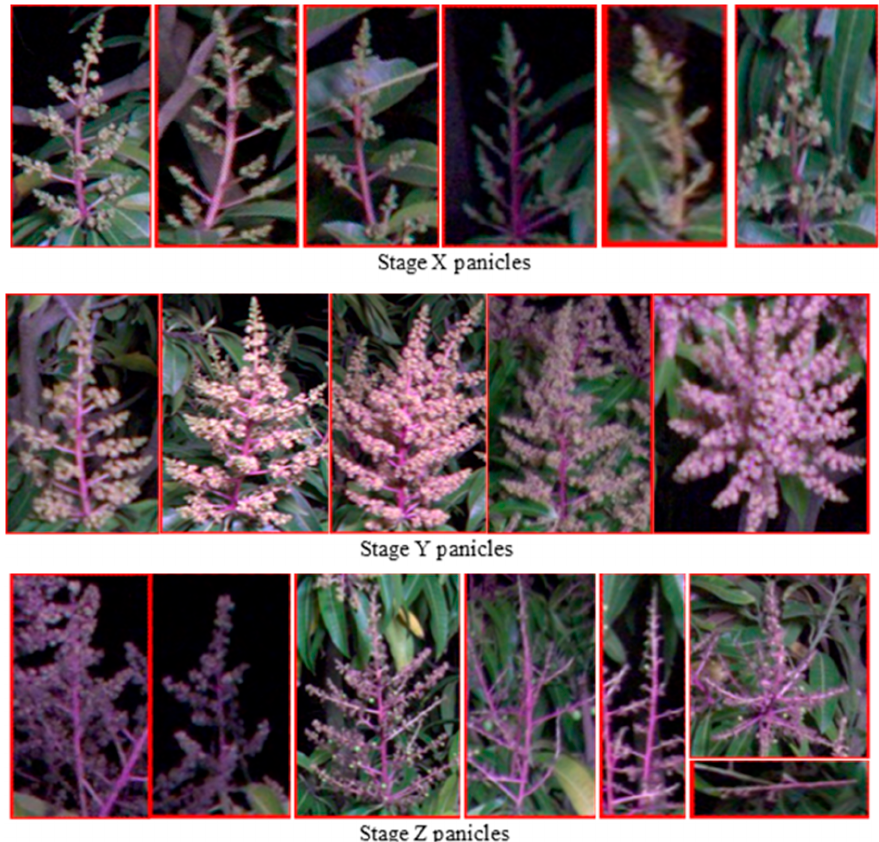
Table 1. Orchard and imaging description.